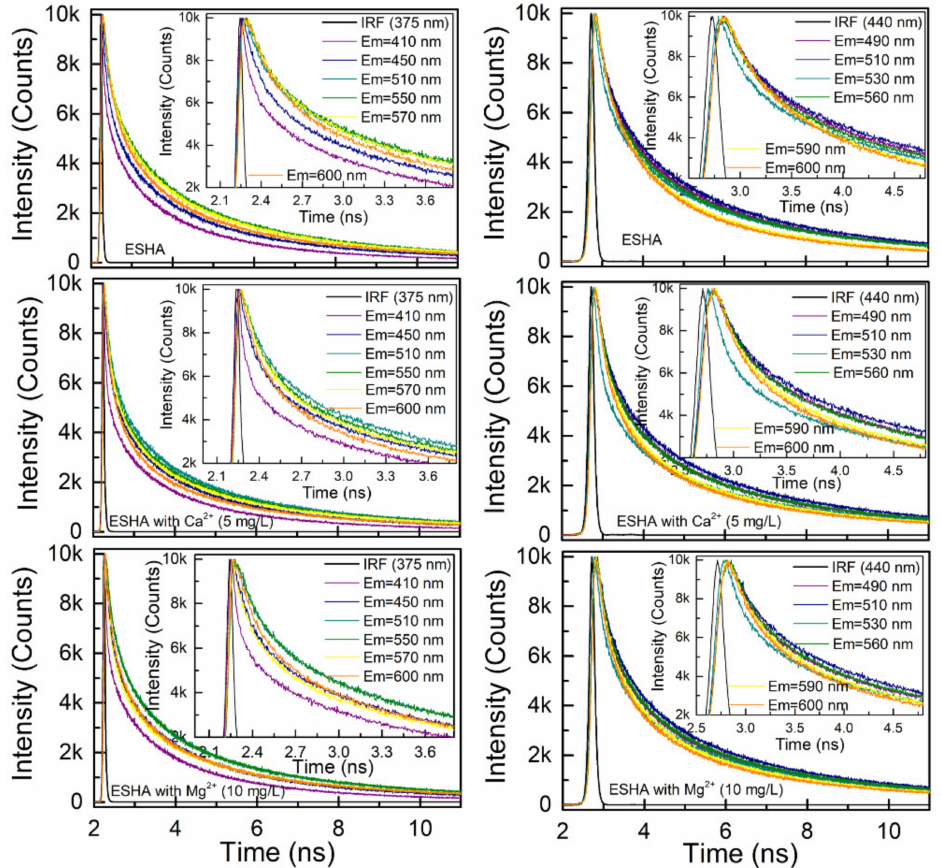
Figure 4. Effects of Mg 2+ (10 mg/L) and Ca 2+ (5 mg/L) on the time-resolved fluorescence spectra of ESHA (10 mg C/L) aqueous solution at excitation of 375 and 440